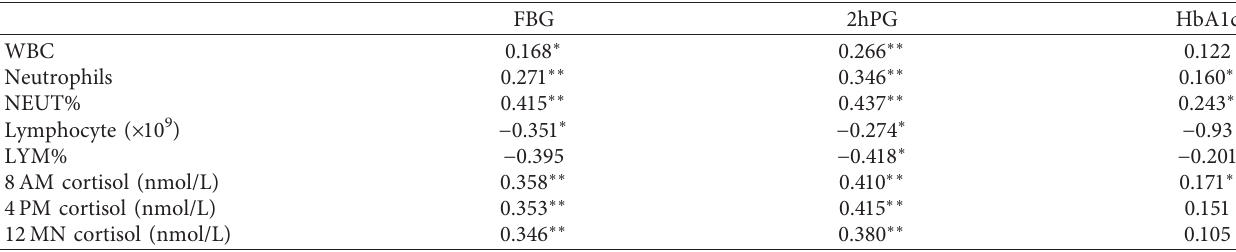
Table 2: Correlation analysis related to glucose homeostasis.